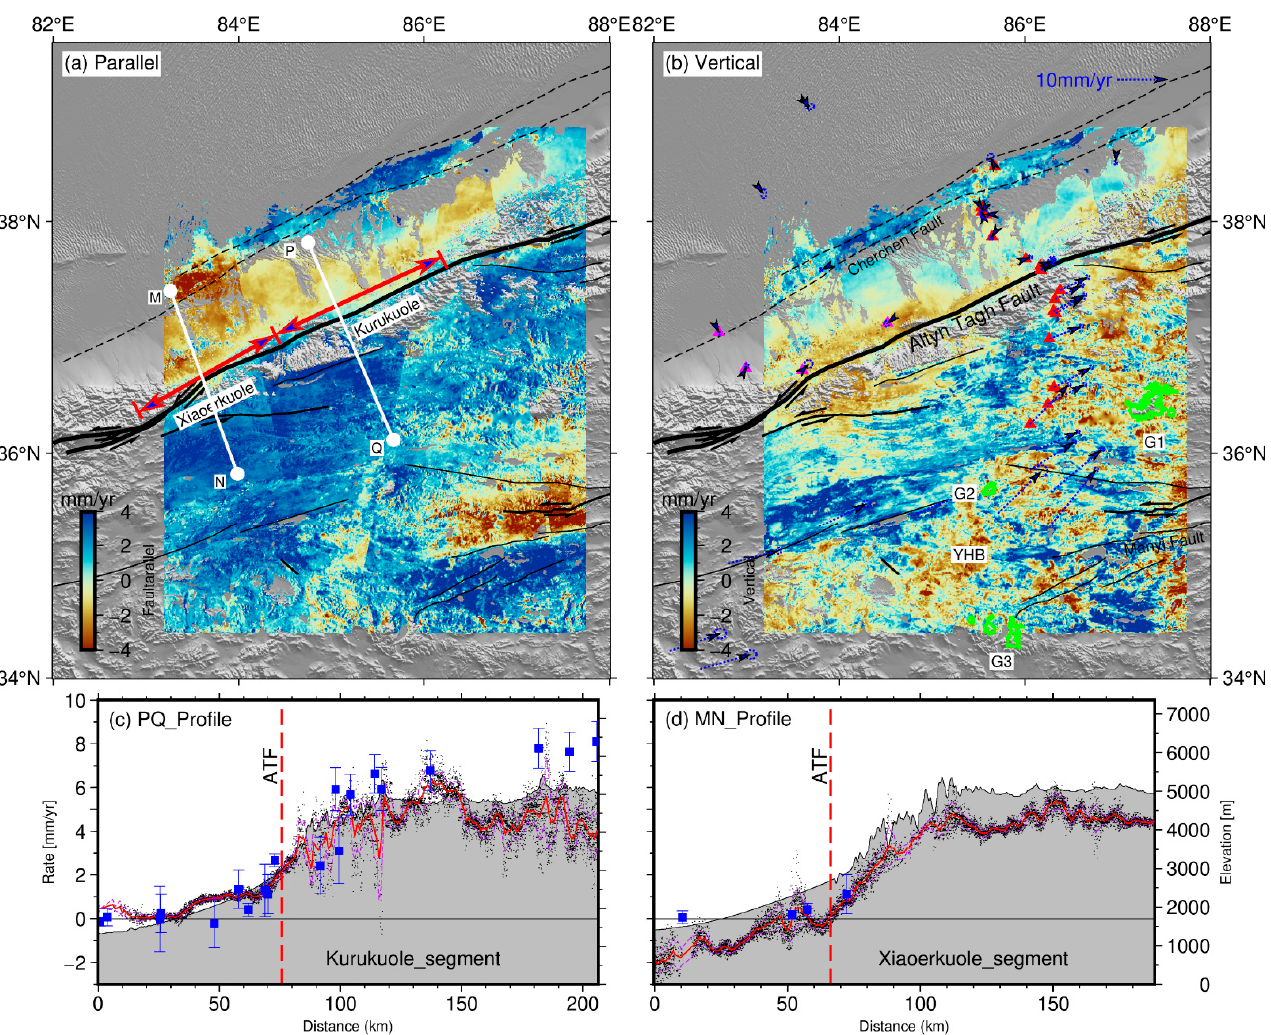
Figure 4. Horizontal and vertical surface velocities for the Altyn west segment region. ( a ) Fault-parallel and ( b ) Vertical components of InSAR observations derived from a combination of ascending and descending LOS directions (Figure 3), assuming a constant horizontal direction of motion of N70°E. The red line segment marks the beginning of the fault segment. ( c ) InSAR fault-parallel velocities within 10 km of the Kulukuole segment crossing profile PQ are shown in ( a ). The blue squares with error bars are the fault-parallel Global Positioning System (GPS) velocities, which location is shown as a red triangle in ( b ). The solid red lines and purple dashed line mark binned mean and standard deviations along with profiles, respectively. ( d ) Same as above but for a profile MN that crosses Xiaoerkule segment of ATF, but GPS stations used are marked with a purple triangle in ( b ). The solid white line indicates the position of the velocity profile, and vertical dashed red lines represent the locations of the ATF. The green line represents the outline of the glacier, and the symbol G1 represents Songzhiling, G2 for Muztag Feng, and G3 for Zangser Kangri. YHB-Yanghu Basin.